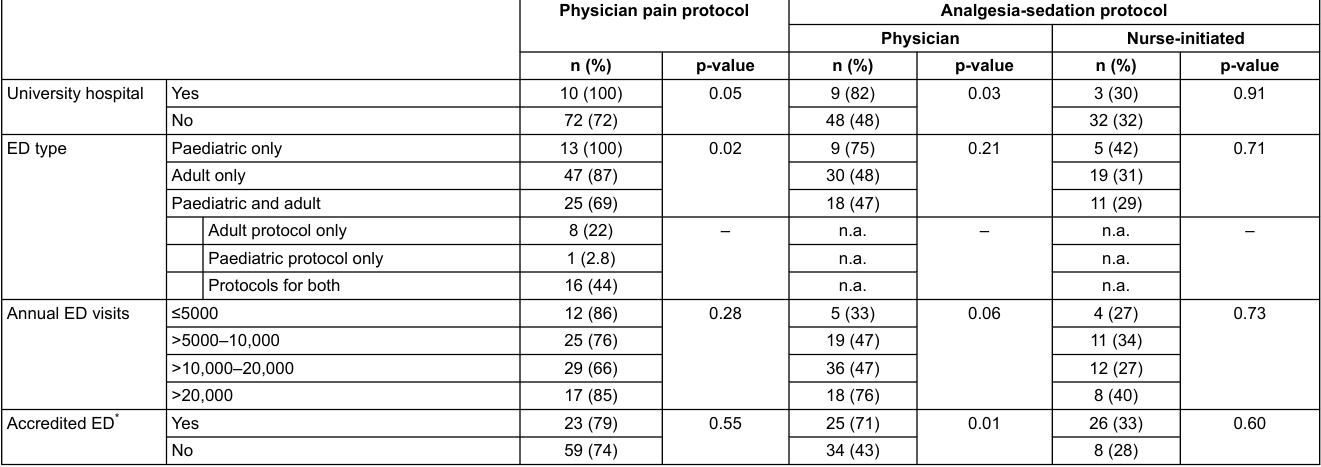
Table 3: Physician pain protocol and analgesia-sedation protocol by emergency department (ED)